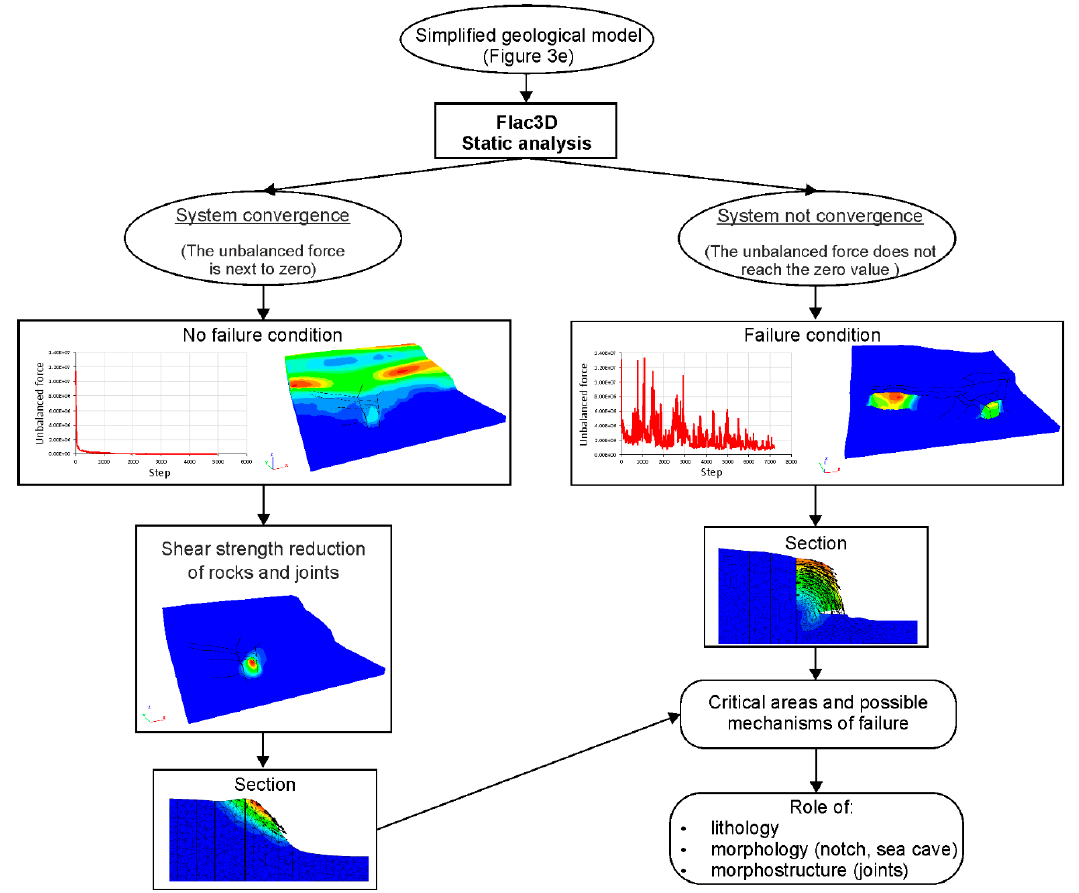
Figure 6. Workflow for the numerical modelling steps.